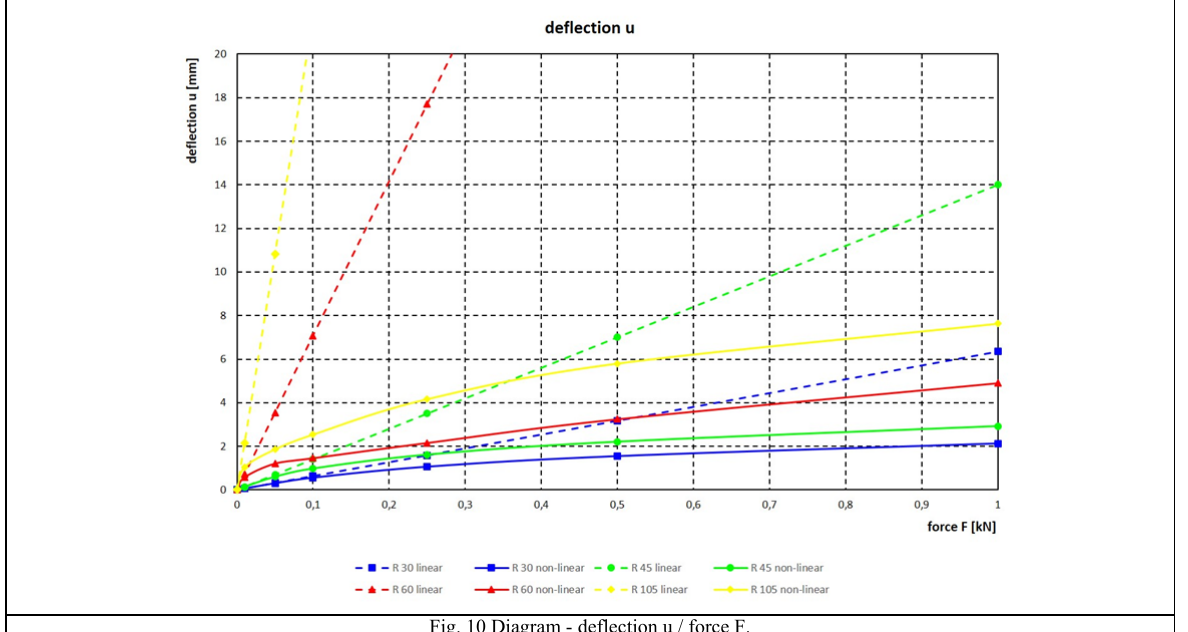
Fig. 10 Diagram - deflection u / force F.